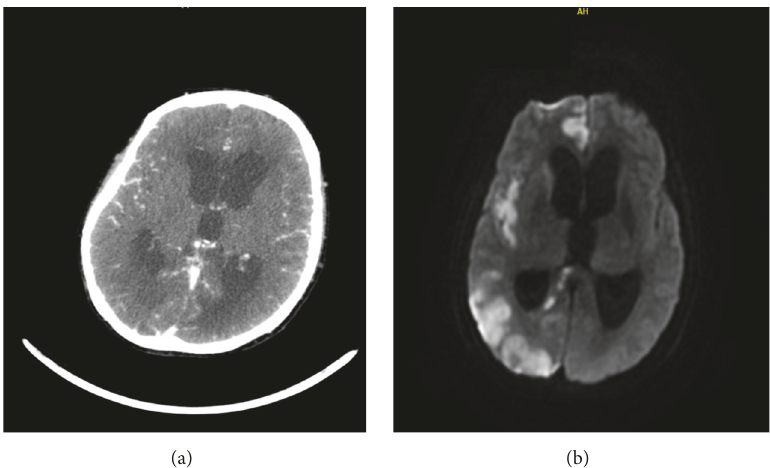
Figure 1: (a) CT angiography of the head showing important supratentorial hydrocephalus with narrowing of cortical sulci and cerebral edema. (b) MRI-scan of the head showing extensive recent ischemia in the cerebellum and dilatation of the third and fourth